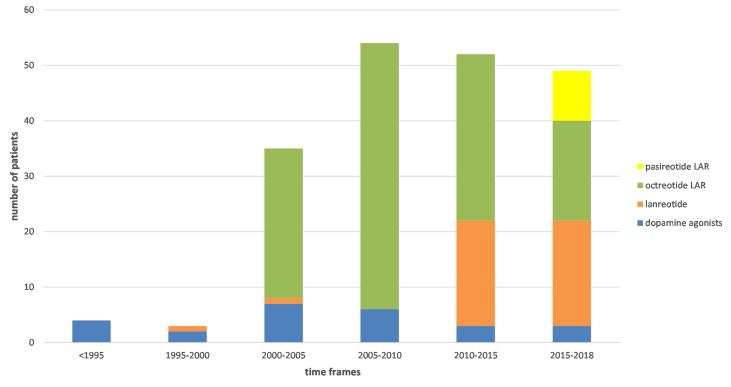
Type of used pharmacotherapy over 5-year time frames.